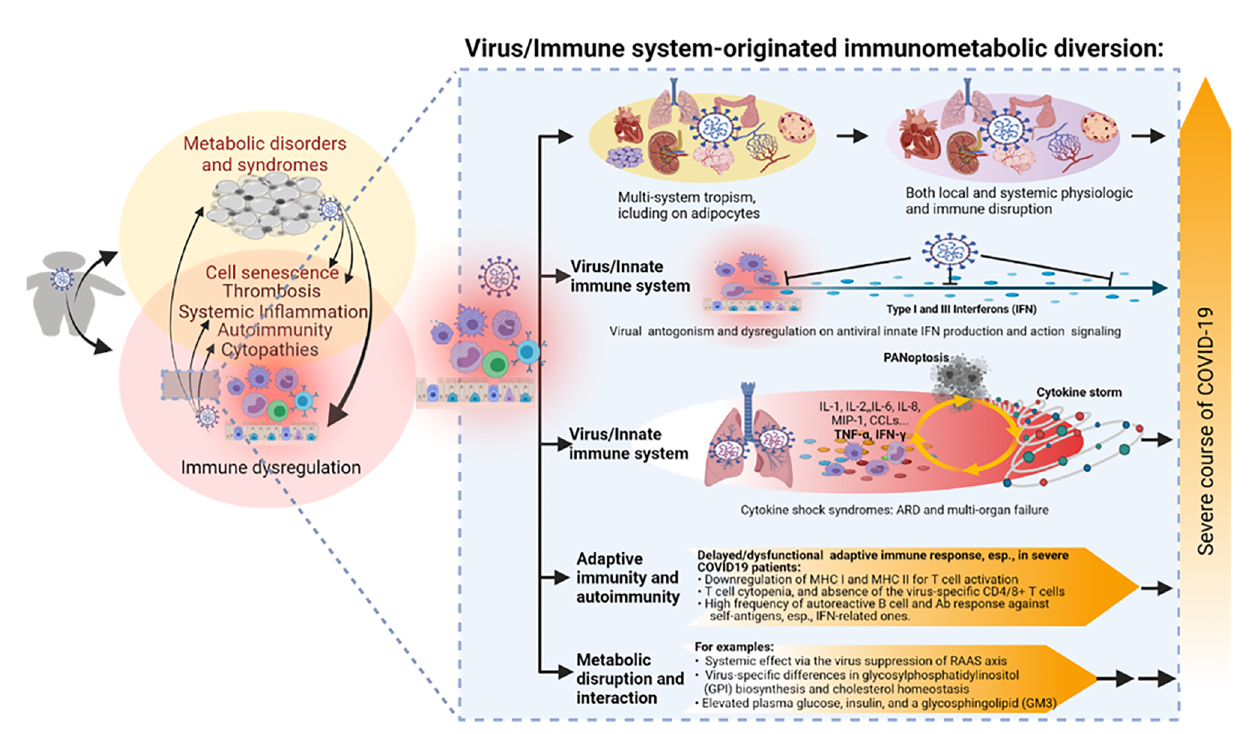
FIGURE 3 | The virus – immune system interaction and relevant immunometabolic dysregulation underlying the association between obesity and the severe course of COVID-19. SARS-CoV-2 is notorious for its broad tissue tropism, including susceptibility that has been demonstrated in the airway, lung, intestine, kidney tubule, pancreatic duct, blood vessel, neuron, and adipocyte cells, implicating metabolic and immune disruption caused by direct viral infections in multiple systems. Studies indicate an extensive virus-immune system interaction at both innate and adaptive immune levels, with emphasis on the viral antagonism against the antiviral IFN system, hyper-in fl ammation incited by massive cell death upon immunopathies induced by the virus – host interaction, as well as various disruptions in adaptive immunity per T-cell- and B-cell-mediated responses. Some metabolic disruption of lipid biosynthesis has also been correlated to COVID-19 progression, but its long- term effect on the development of metabolic disorders in convalescent patients warrants further studies. PANoptosis, massive in fl ammatory cell death including Pytoptosis, Apoptosis, and Necroptosis. Other abbreviations are as listed in Figure 2